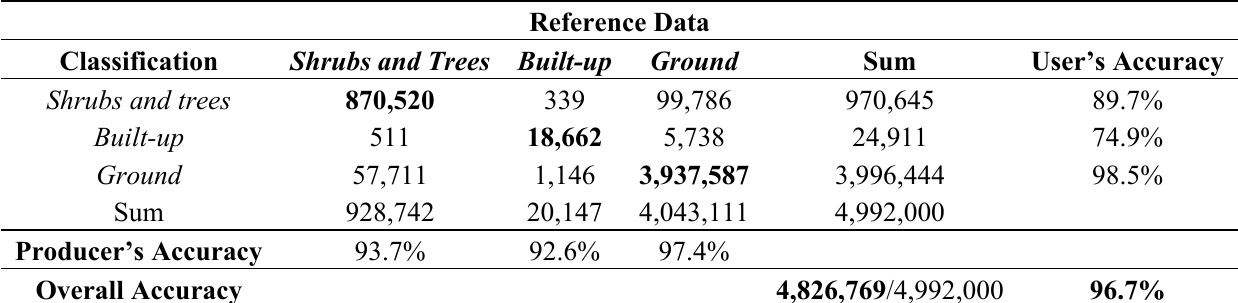
Table 5. Confusion matrix and accuracy estimates for the classification based on the nDSM and CIR orthoimages and the feature SUM/NIR derived from the CART analysis.